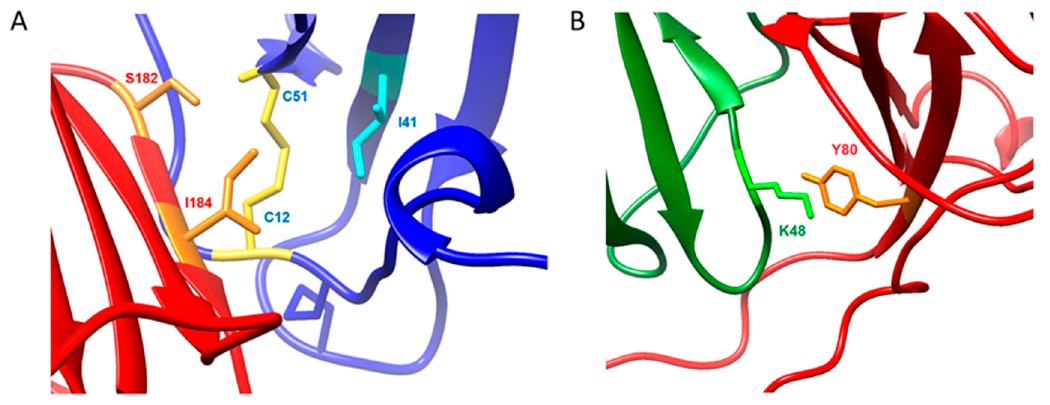
Figure 7. Interactions illuminated by molecular dynamics simulation of the vCCI:MIP-1 β and vCCI:vMIP-II complex. vCCI is in red ribbon in both instances, bound vMIP-II is in blue ribbon, and bound MIP-1 β is in green ribbon. (A) Interaction between I184 of vCCI (orange) and I41 of vMIP-II (cyan), as well as S182 of vCCI (orange) with the backbone of C51 of vMIP-II (yellow). C12 of vMIP-II is also indicated in yellow; (B) Interaction between Y80 of vCCI (orange) and the backbone of K48 of MIP-1 β (green).